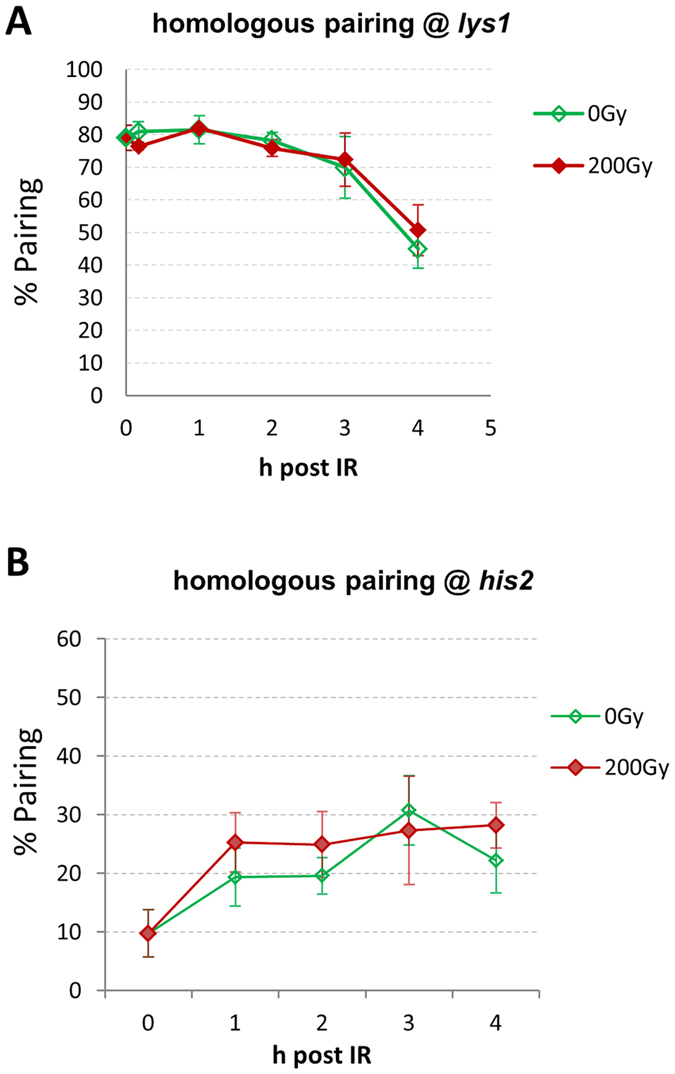
Homologous chromosome pairing is not affected by IR.(A) Pairing of LacI-GFP dots at lys1 (close to centromere 1) is similar in control (0 Gy) and 200 Gy X-irradiated horsetail cells 3 h post induction. (B) The pairing at his2 (interstitial region on chromosome 2) was slightly but insignificantly faster in the first hour post IR but remained on a similar level to control (0 Gy) between 1 h and 4 h after irradiation with 200 Gy 1 h post induction. The differences being insignificant.